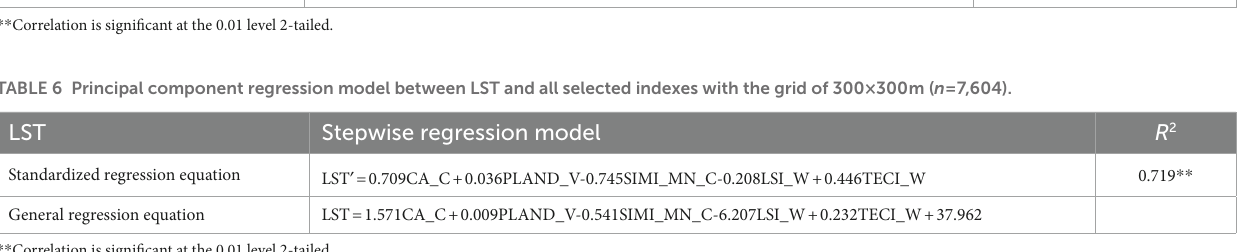
TABLE 5 Principal component regression model between LST and water-related variables ( n = 7,604). LST Stepwise regression model Standardized regression equation